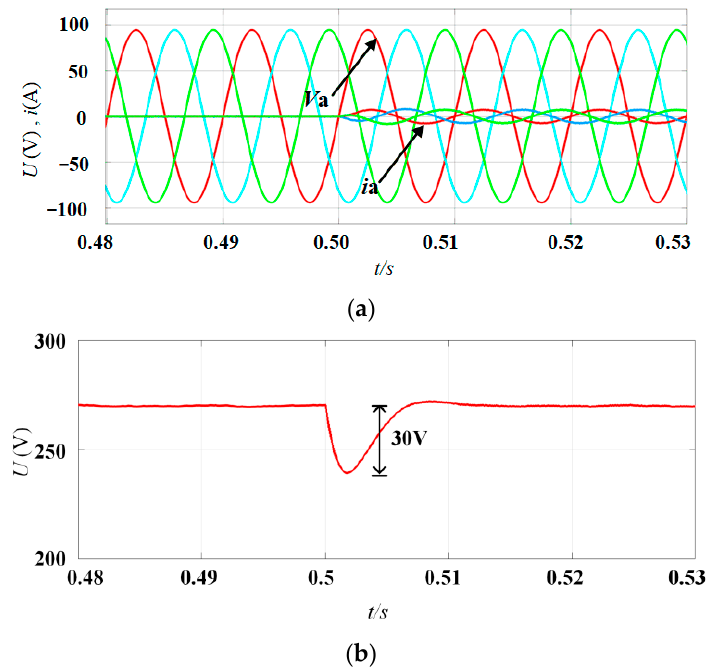
Figure 10. Feasibility Analysis: ( a ) three-phase AC voltage and three-phase AC current; ( b ) DC-link voltage.